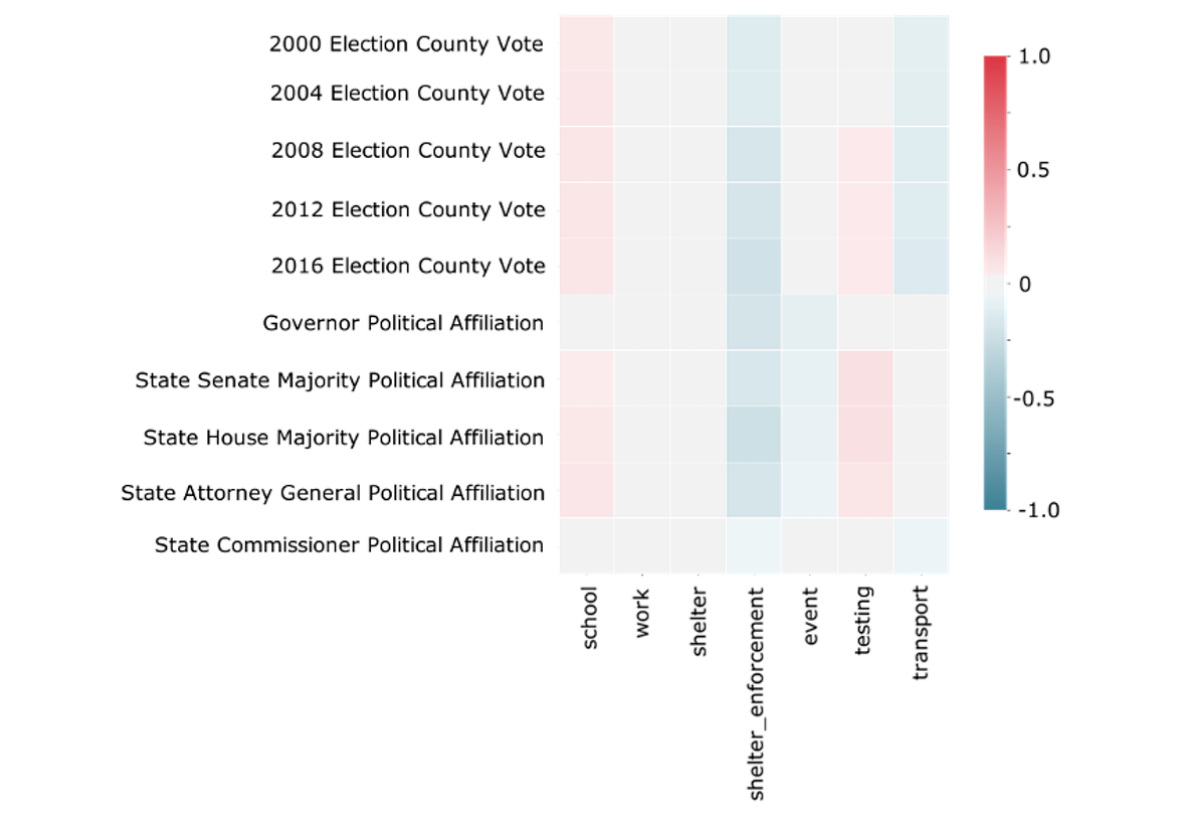
Figure 4. Weak correlation between county policies and county political parties. Correlogram of county-level nonpharmacologic interventions (NPIs) and political election patterns for state and national government for the all policies data set. A positive correlation shown in red indicates a positive correlation between a Republican-oriented election pattern and an